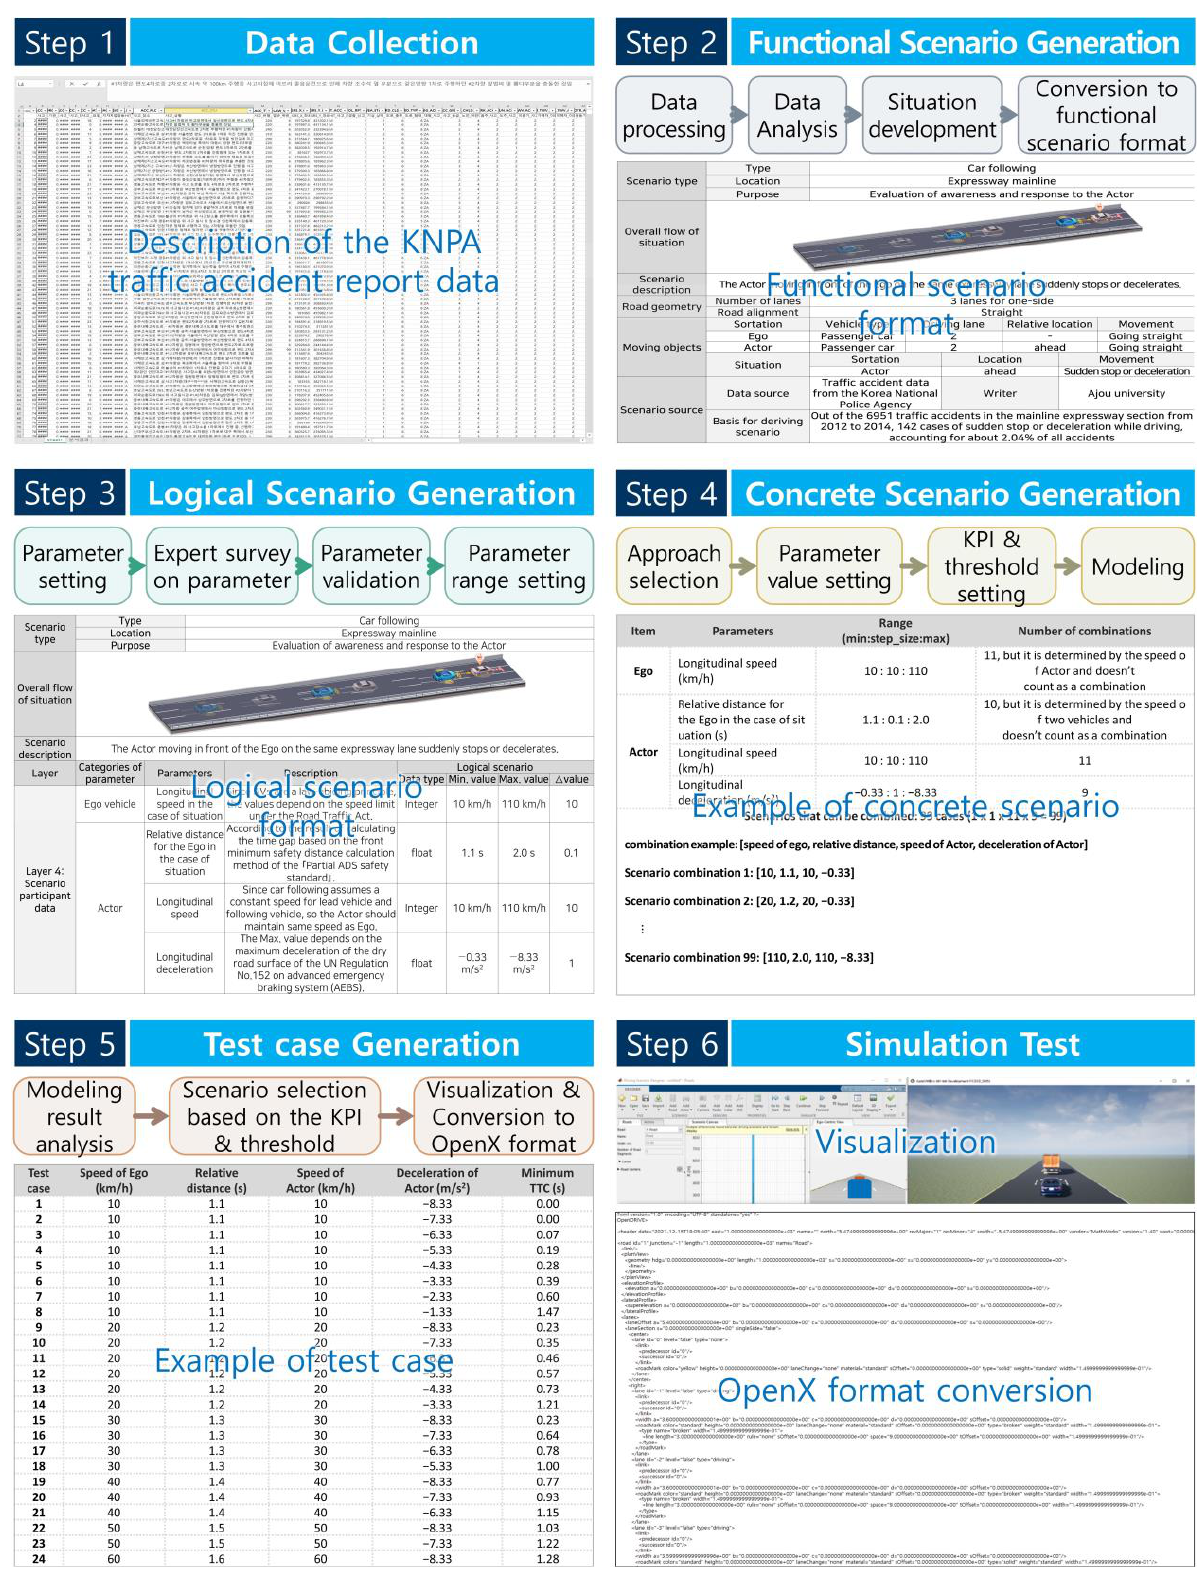
Figure 1. Scenario generation